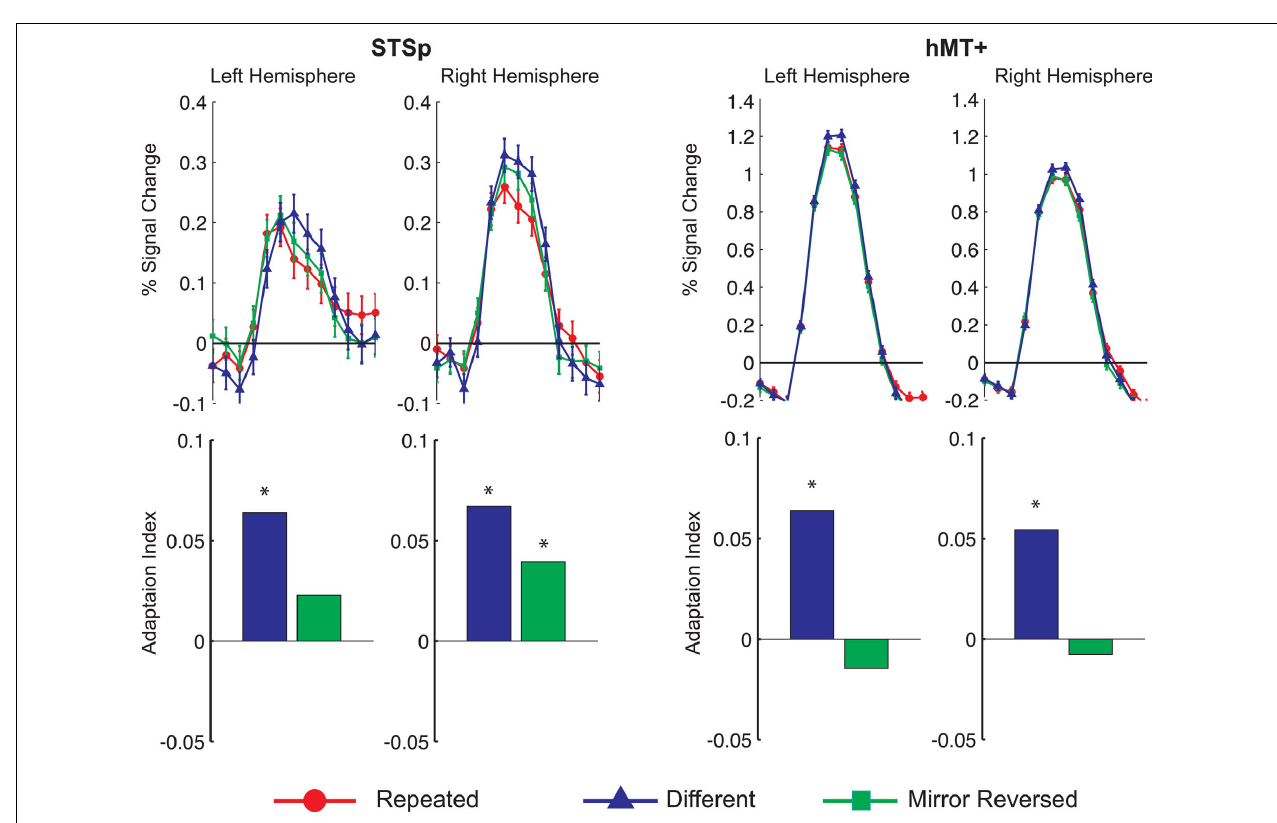
FIGURE 3 | Average deconvolved hemodynamic response functions and the corresponding adaptation indices for each hemisphere of the STSp (left) and hMT + (right) for Experiment 1. *Indicates statistically signifi cant different peak